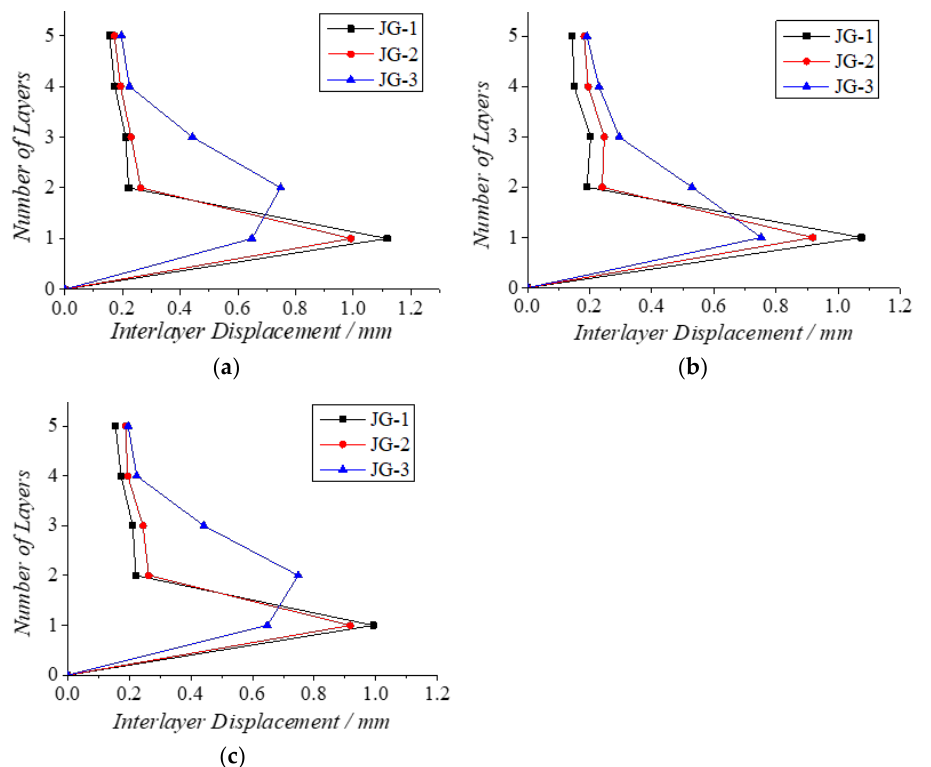
Figure 19. The interlayer displacement. ( a ) Interlayer displacement under the action of EL-Centro wave; ( b ) interlayer displacement under the action of Taft wave; ( c ) interlayer displacement under the action of TJYY wave.